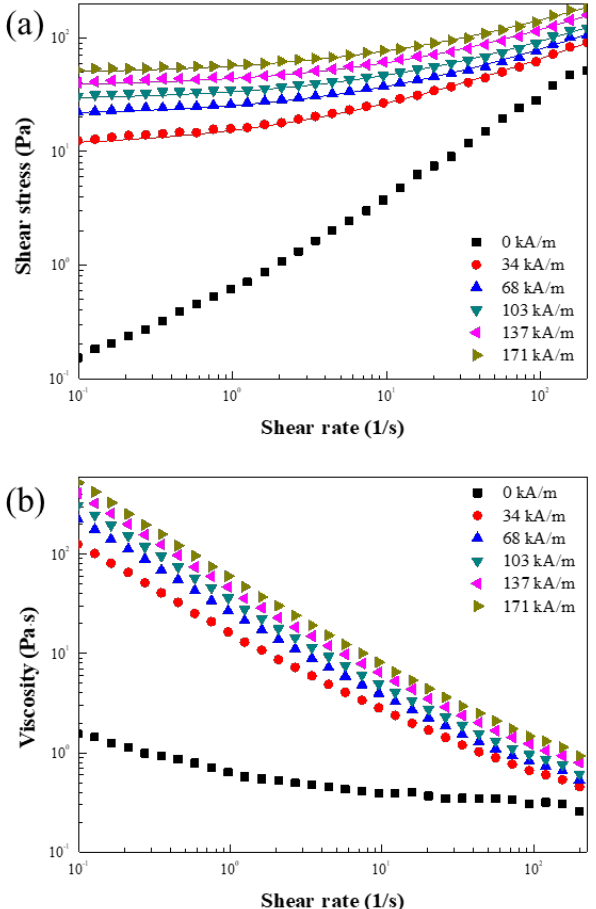
. γ for the MR fluid under H from 0